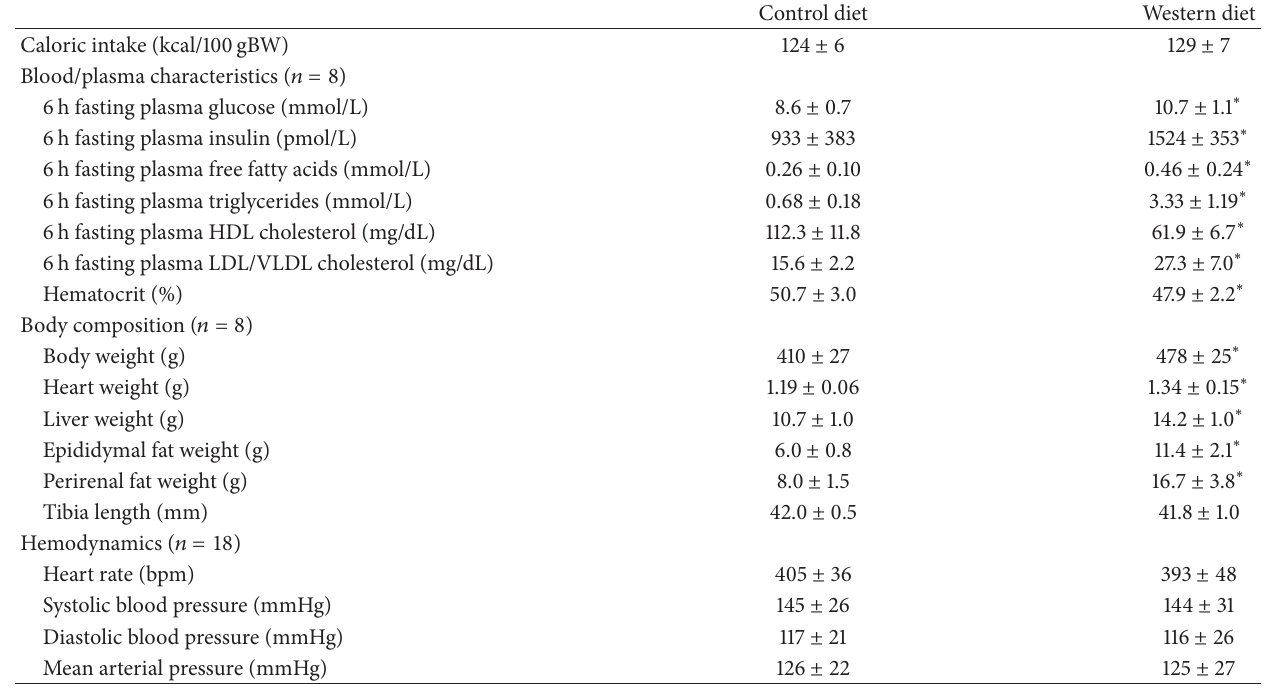
Table 1: Characteristics after 8 weeks of diet feeding.